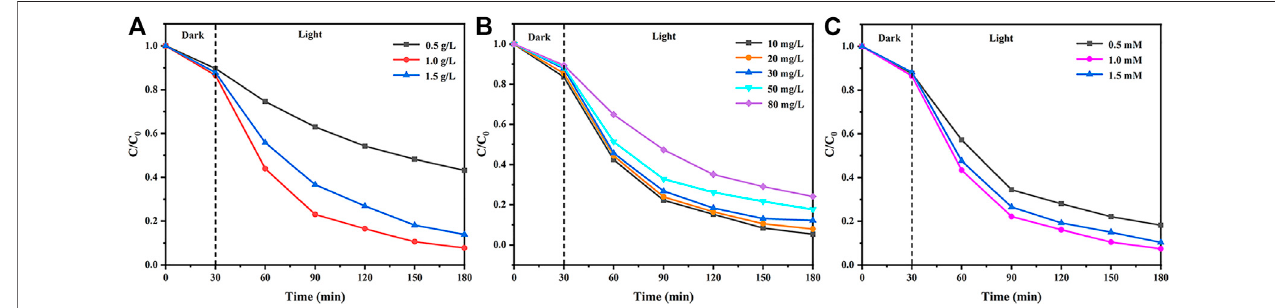
FIGURE 10 | Effect of (A) catalyst dosage (B) initial concentration, and (C) amount of H 2 O 2 on the removal of TCH for ZF-Sep-11. Reaction conditions (TCH) (cid:1) 20 mg/L (catalysts) (cid:1) 1.0 g/L (H 2 O 2 ) (cid:1) 1 mM.